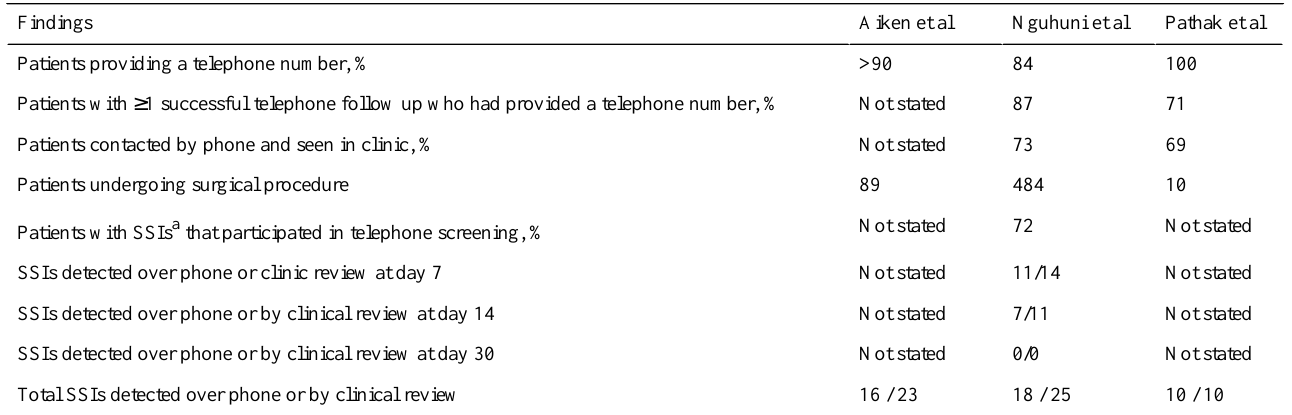
Table 2. Summary of findings.